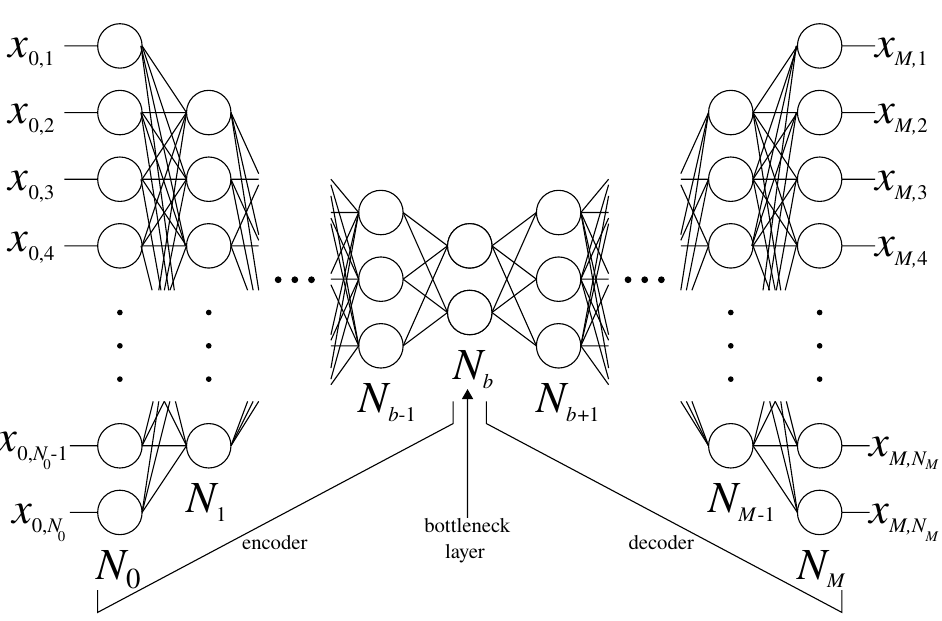
Figure 1 . Schematic diagram of an autoencoder. Each circle represents one